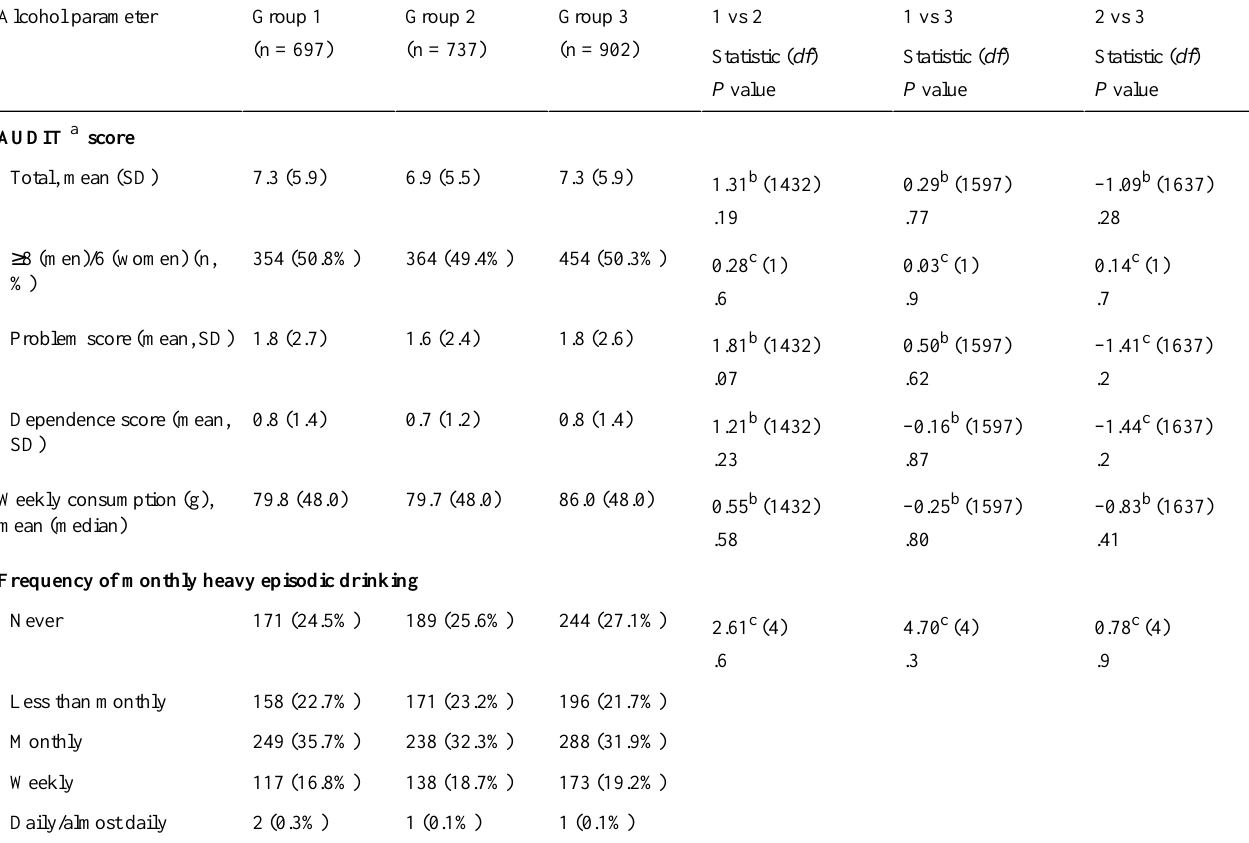
Table 3. Intention-to-treat analyses of groups 1, 2, and 3 (total n = 2336): sample characteristics at follow-up and pairwise comparisons between groups 1 and